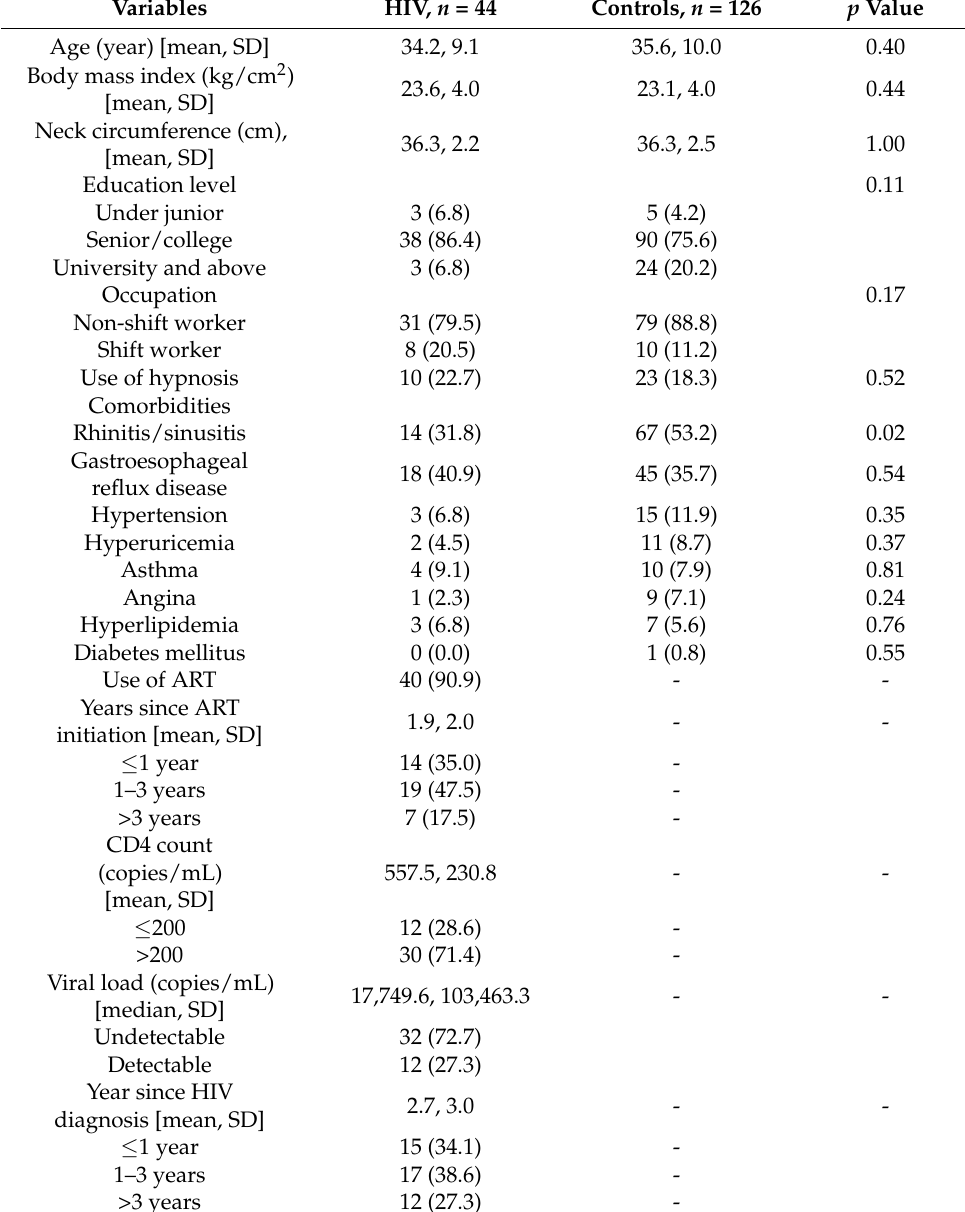
Table 1. Participant demographics ( n =